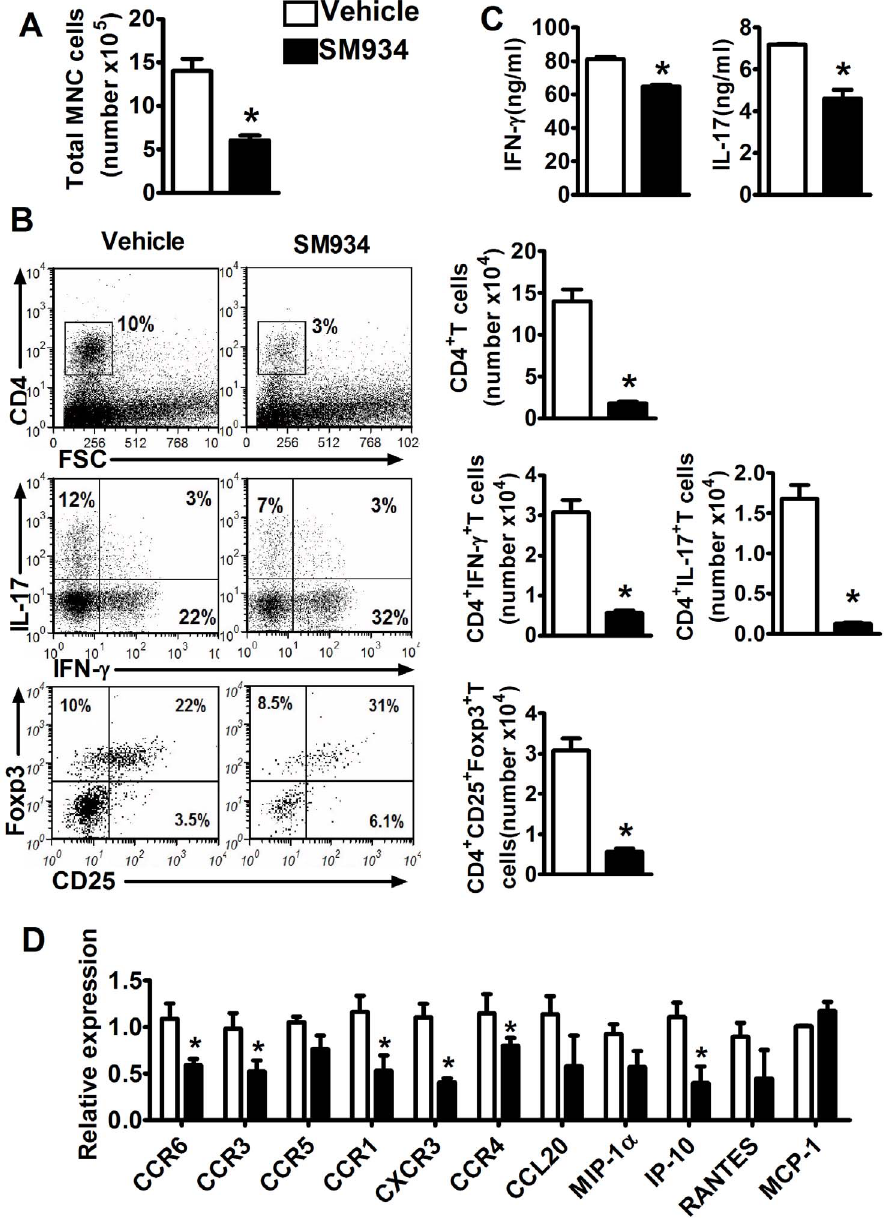
Figure 4. SM934 reduced encephalitogenic cells infiltrating into the CNS. Spinal cord were detached from EAE mice at the peak of disease (day 18), infiltrated mononuclear cells were isolated by density gradient centrifugation, (A) cell number were counted, (B) intracellular IFN- c , IL-17 and Foxp3 in the CD4 + T cells were analyzed by flow cytometry, absolute number of CD4 + IFN- c + , CD4 + IL-17 + , CD4 + CD25 + Foxp3 + cells were calculated. (C) Isolated MNC were stimulated with IL-12 (20 ng/ml) or IL-23 (20 ng/ml) for 72 hours, supernatants were collected to measure IFN- c and IL-17 levels, respectively. (D) Spinal cord were isolated and analyzed by real-time PCR for expression of indicated chemokines and receptors. Results were expressed as mean 6 SEM. *, p , 0.05 compared with vehicle control. Three independent experiments were performed with similar